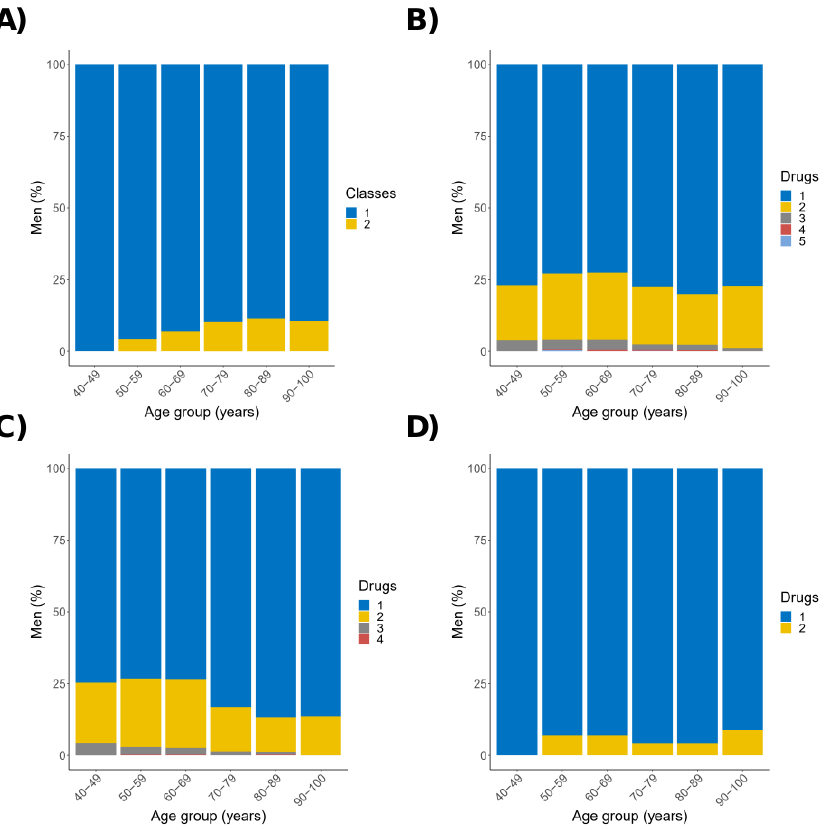
Figure 3. Prescription of drugs for the treatment of BPH/BPO-associated LUTS in the pre-specified age groups. ( A ) Distribution of men with respect to the number of pharmacological classes (Classes) prescribed; ( B ) Distribution of men with respect to the number of drugs (Drugs) prescribed; ( C ) Distribution of men with respect to the number of ABs (Drugs) prescribed; ( D ) Distribution of men with respect to the number of 5ARIs (Drugs) prescribed. Table 3. Drugs prescribed and age of men.